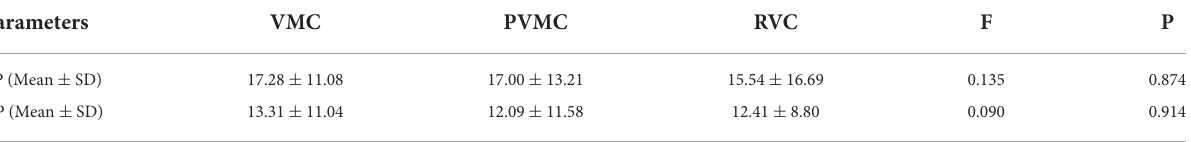
TABLE 3 Characteristics of nystagmus induced by caloric tests.